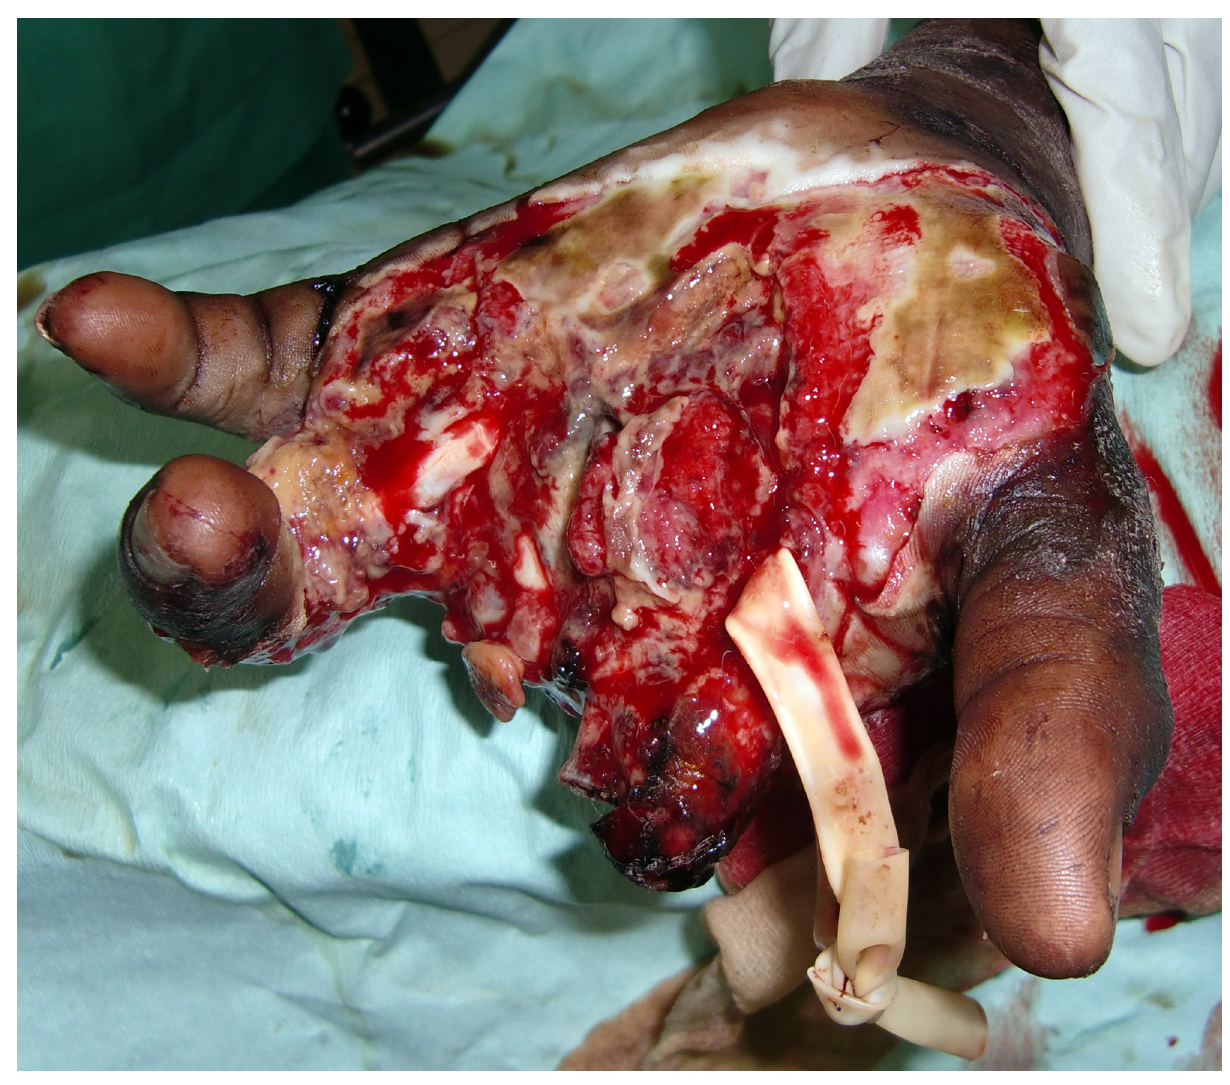
Figure 12. Finger amputation and necrosis, third